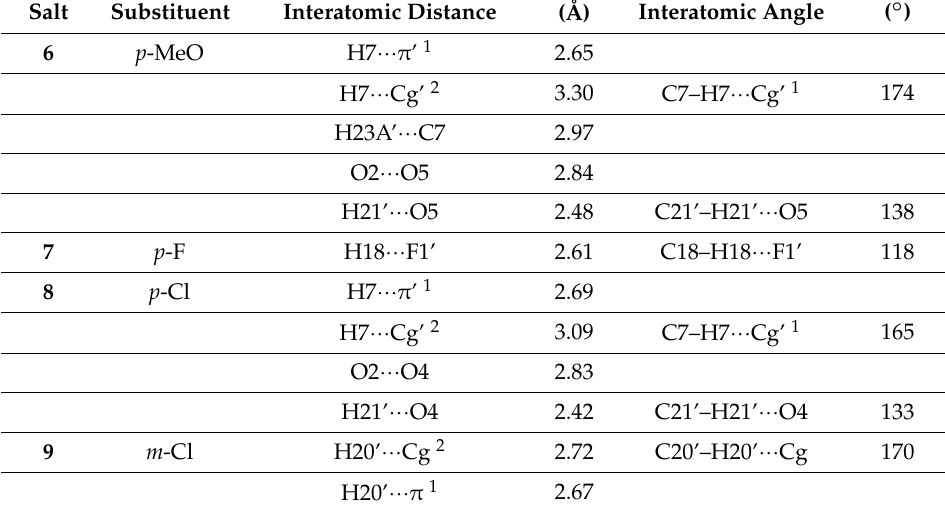
Table 6. Interatomic distances and angles between the sheet structures of salts 6–9 .